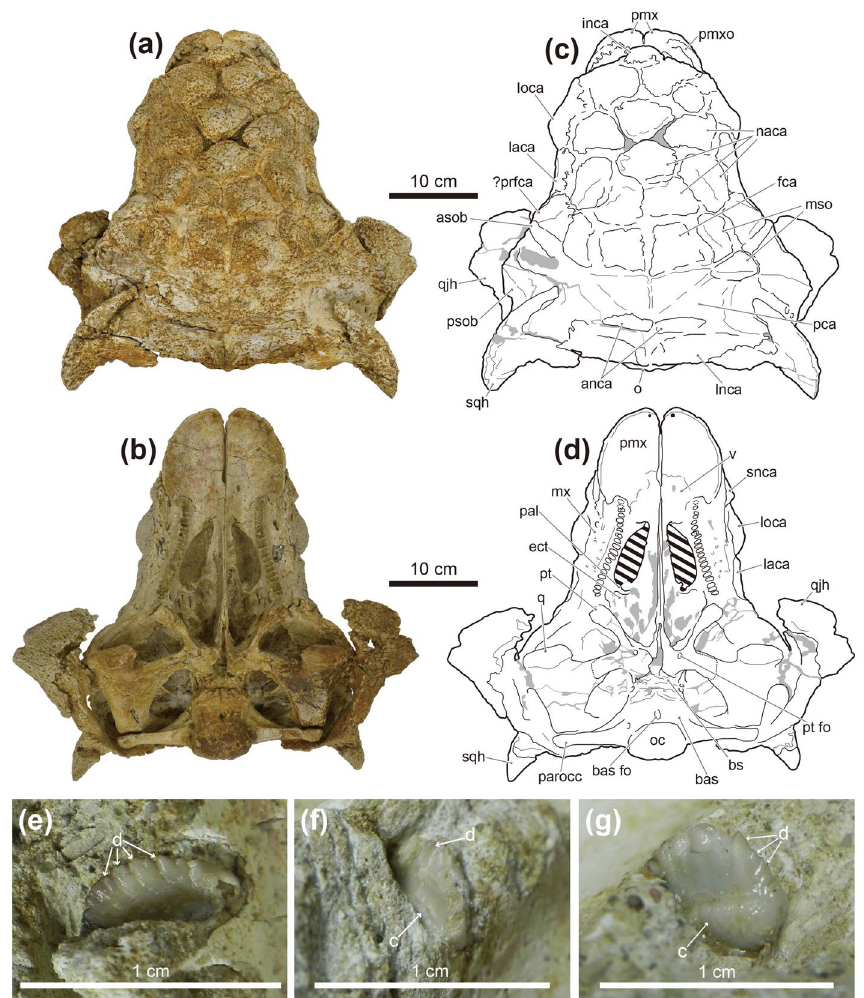
Figure 3. Photographs ( a and b ) and line drawings ( c and d ) of the skull, and photographs of the maxillary teeth ( e – g ) of Tarchia tumanovae sp. nov. (MPC-D 100/1353). Photographs of the skull in ( a ) dorsal and ( b ) palatal views. Line drawings in ( c ) dorsal and ( d ) palatal views. Grey areas indicate damaged surfaces, and solid diagonal lines indicate unremoved matrix. Photographs of ( e ) seventh left, ( f ) third right, and ( g ) eight right maxillary teeth in anterolabial view. anca anterolateral nuchal caputegulum, asob anterior supraorbital caputegulum, bas basioccipital, bas fo basioccipital foramen, bs basisphenoid, c cingulum, d denticle, ect ectopterygoid, fca frontal caputegulum, inca internarial caputegulum, laca lacrimal caputegulum, lnca lateral nuchal caputegulum, loca loreal caputegulum, mnca medial nuchal caputegulum, mso middle supraorbital caputegulae, mx maxilla, naca nasal caputegulum, oc occipital condyle, pal palatine, parocc paroccipital process, pca parietal caputegulum, pmx premaxilla, pmxo premaxillary ornamentation, prfca prefrontal caputegulum, psob posterior supraorbital caputegulum, pt pterygoid, pt fo pterygoid foramen, q quadrate, qjh quadratojugal horn, snca supranarial caputegulum, sqh squamosal horn, v vomer. Adobe Illustrator CC (version 24.0.1, https:// www. adobe. com/ kr/ produ cts/ illus trator. html) was employed to produce ( c and d